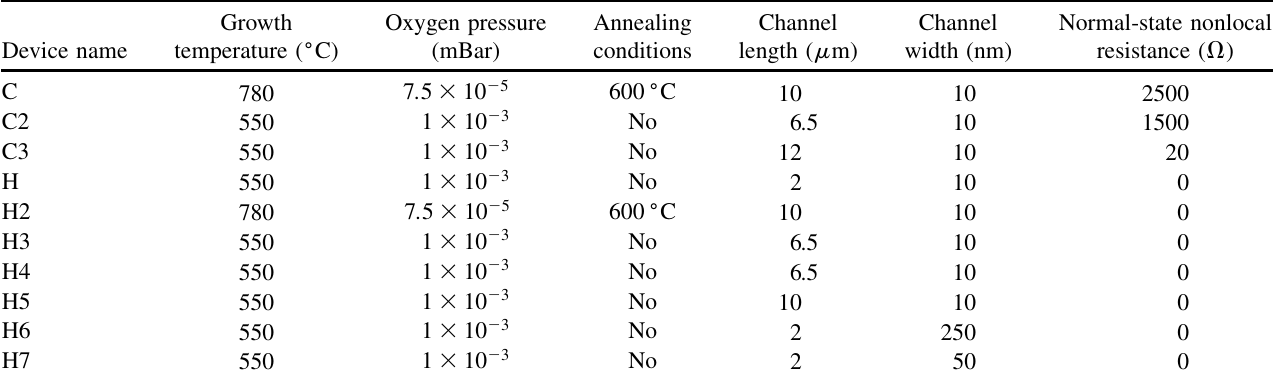
TABLE I. Device growth parameters and transport characteristics.